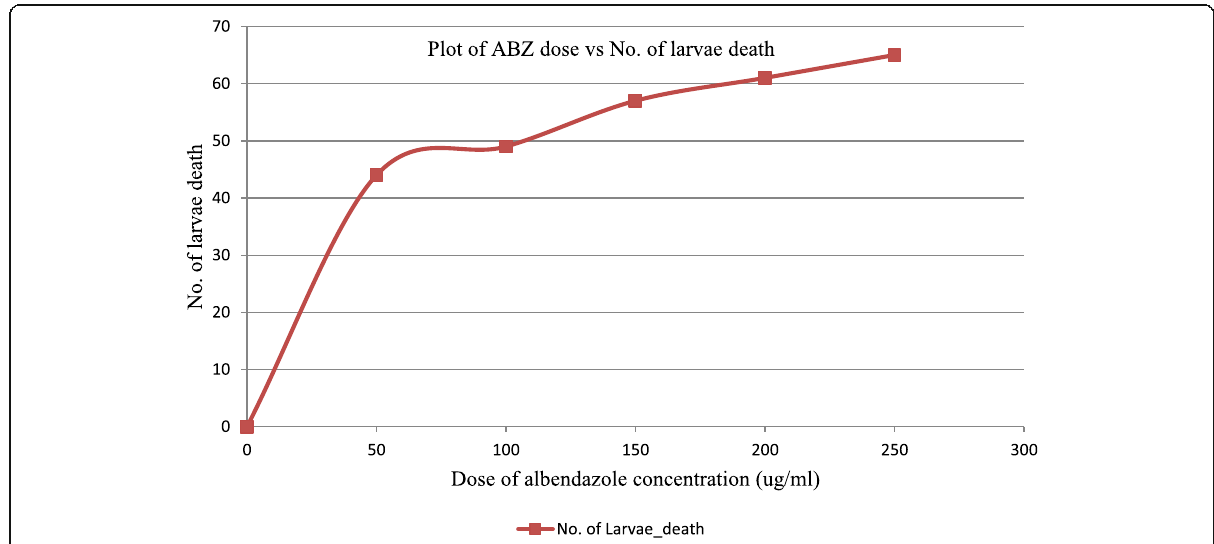
Fig. 1 In vitro dose response curve of different albendazole concentration against hookworm larvae